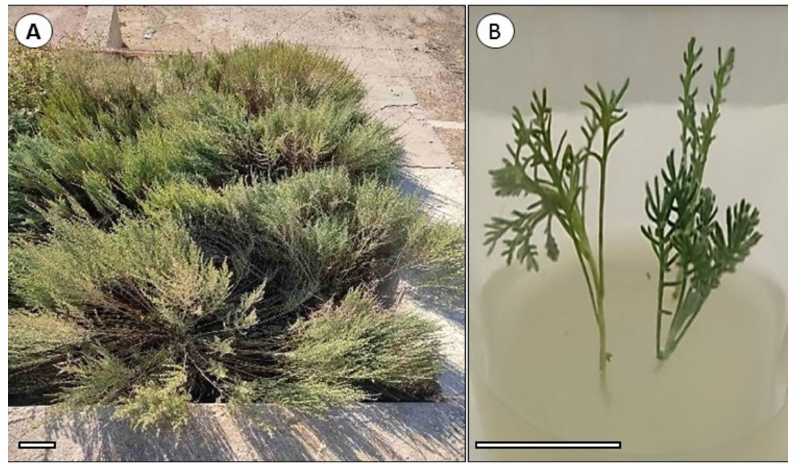
Figure 3. Plants of Artemisia balchanorum , cultivar 130; ( A ) 3-year-old plant in October 2019 (bar = 10 cm), ( B ) microcutting in vitro (bar = 5